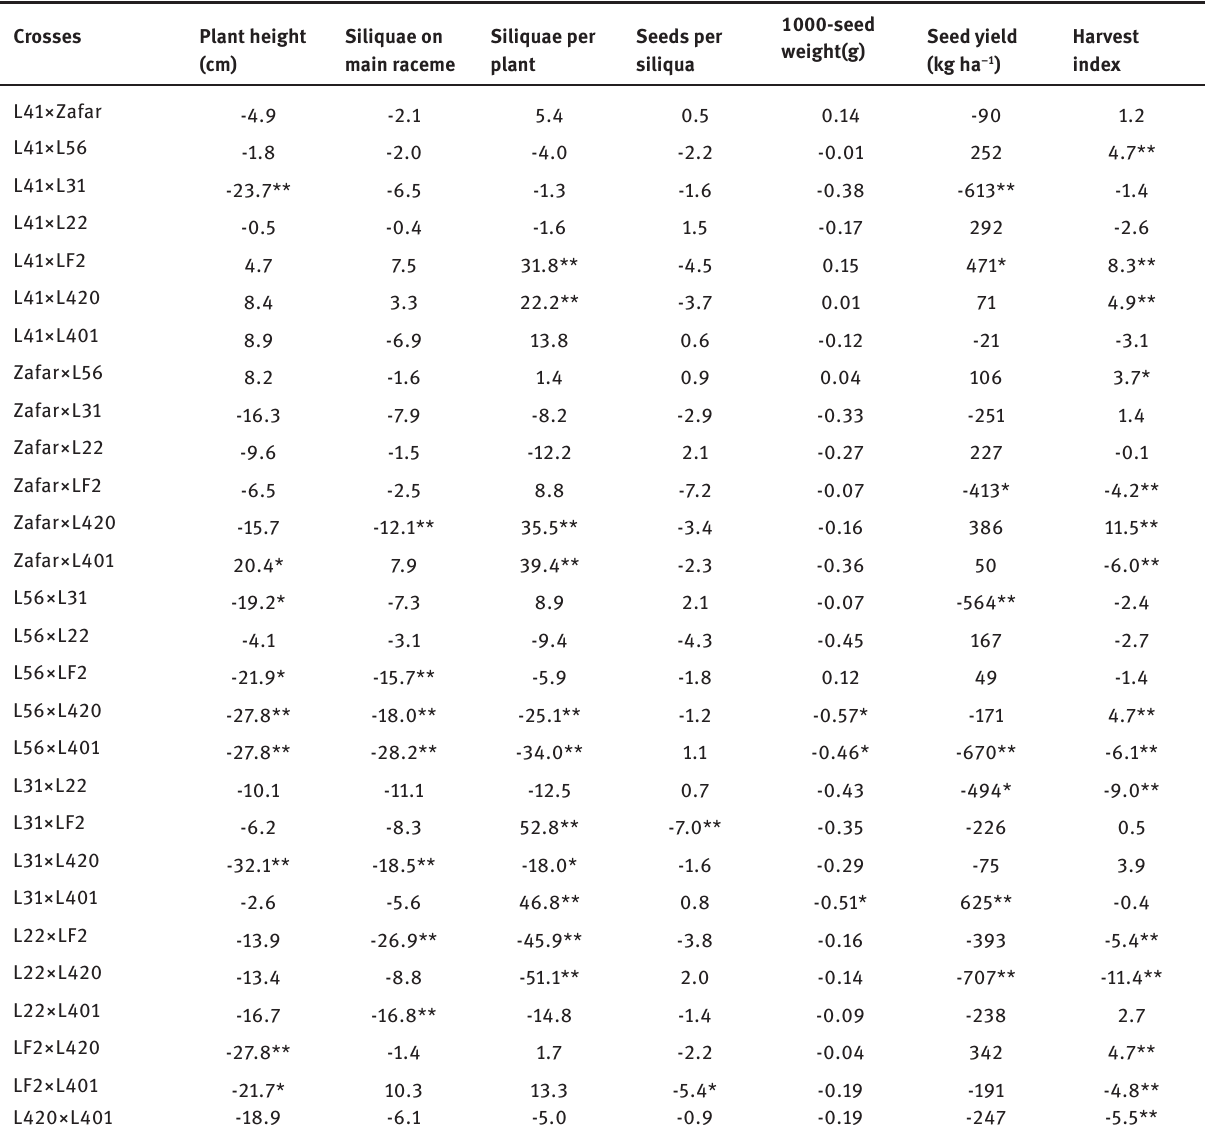
Table 5: Heterobeltiosis of oilseed rape crosses for yield associated traits in half diallel crosses of eight oilseed rape genotypes